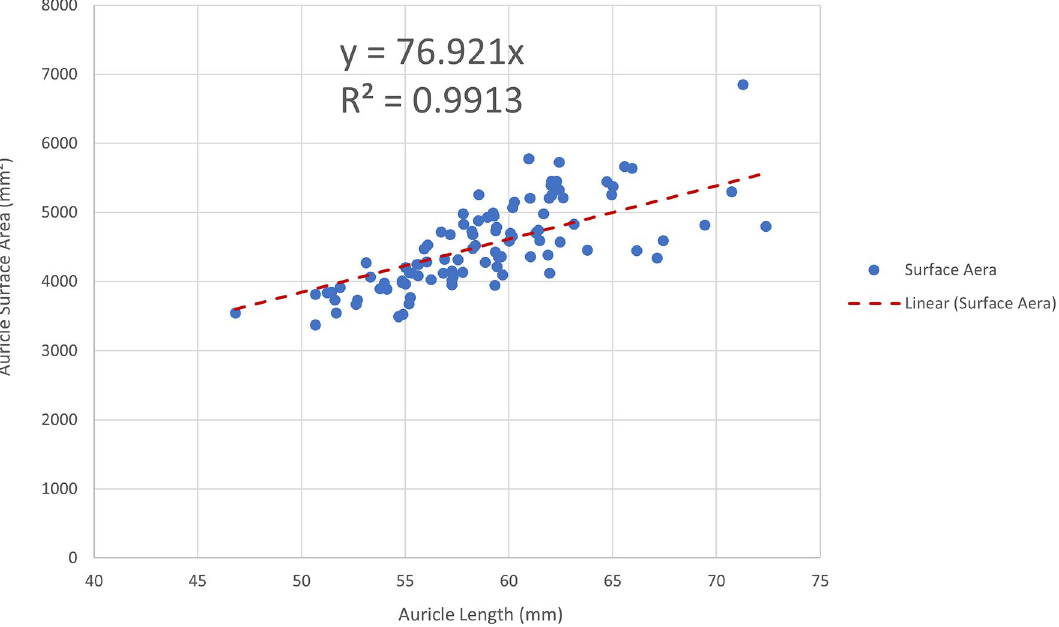
Figure 1. The scatter plot, linear trendline, and equation that demonstrate the relationship between auricle length and surface area. R 2 , coefficient of